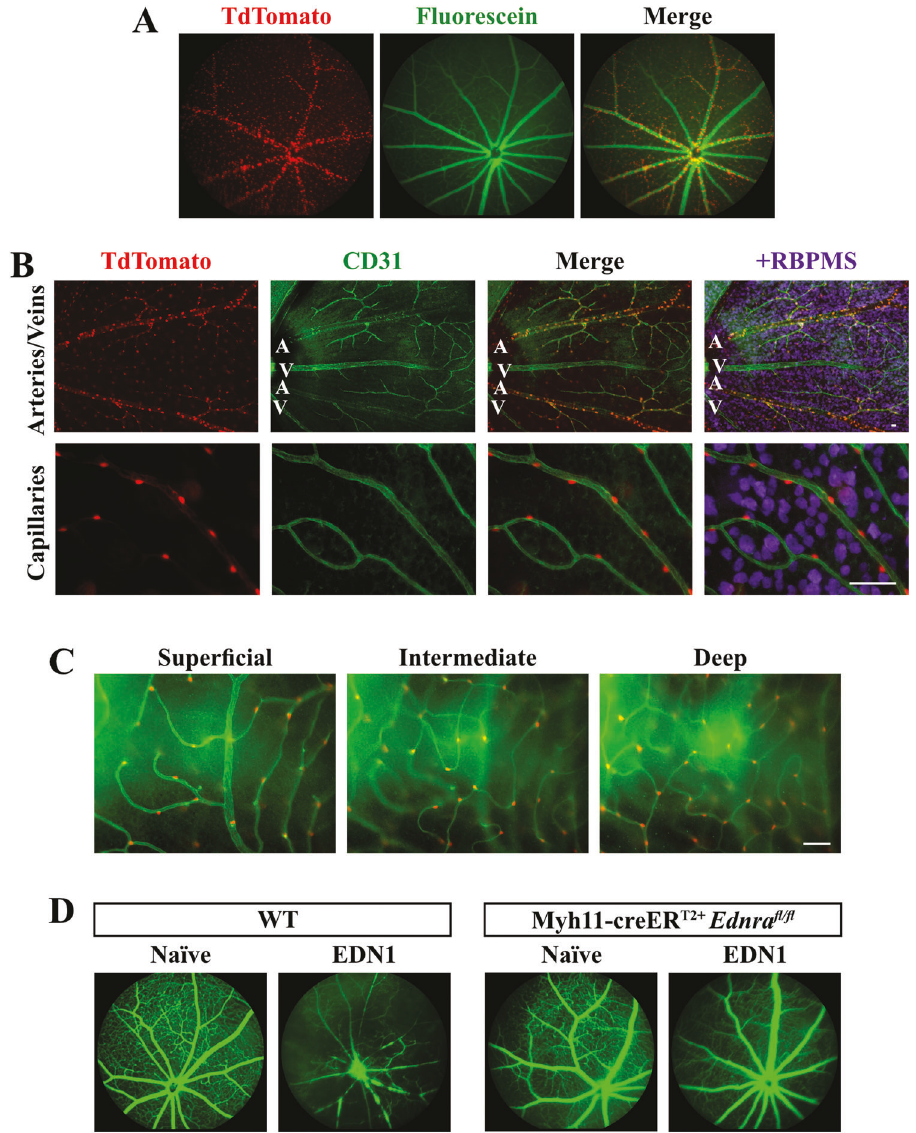
Fig. 4 Myh11-creER T2 recombined fl oxed alleles in vascular mural cells. A Myh11-creER T2 + Tdtomato + fl uorescein angiography overlayed with TdTomato fl uorescence demonstrating TdTomato localization to retinal arteries ( n = 4). B Myh11-creER T2 Tdtomato + retinal fl at mounts counterstained with CD31 to visualize retinal vasculature. Tdtomato was robustly and speci fi cally expressed by arterial cells and capillaries, but not by RBPMS + RGCs or any other observable cell type. C Tdtomato + cells surrounding retinal capillaries were apparent in super fi cial, intermediate, and deep layers of the retina ( n = 3). Scale bars, 50 μ m. D Fluorescein angiography of retinal vasculature in naive and EDN1- injected eyes from WT and Myh11-creER T2 + Ednra fl / fl animals. Mural cell-speci fi c deletion of Ednra ablated EDN1-induced vasoconstriction ( n ≥